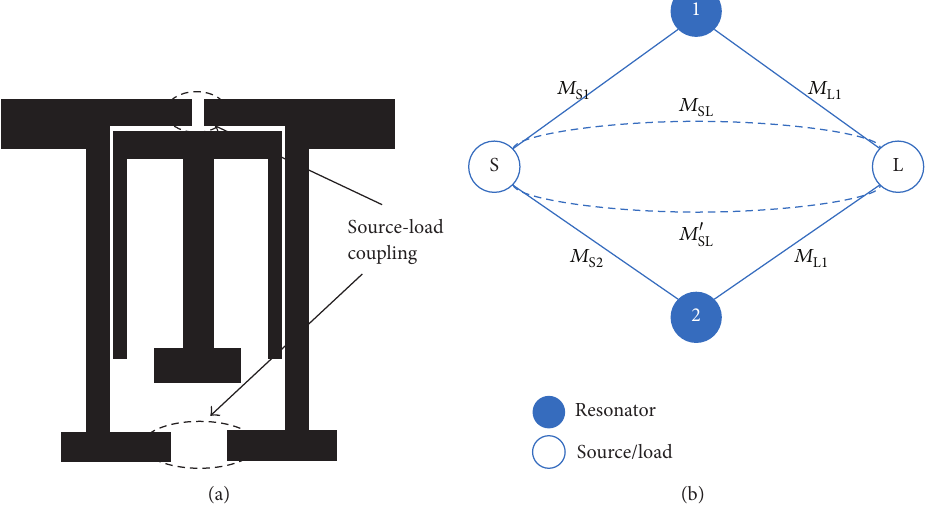
Figure 4: Coupling topology of the proposed